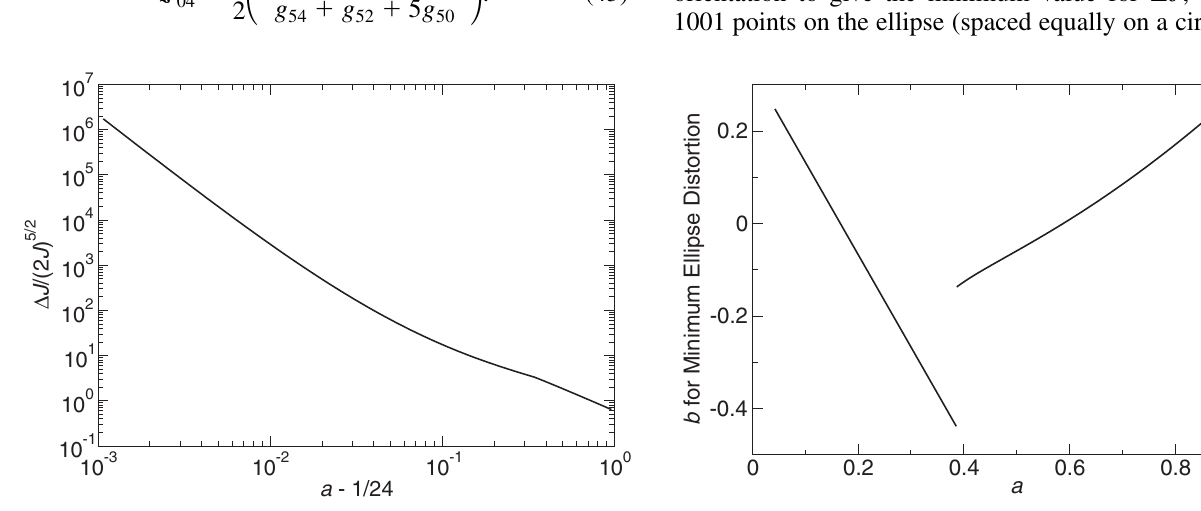
FIG. 9. Value for b which gives the minimum ellipse distortion when the center and ellipse shape are allowed to change with J